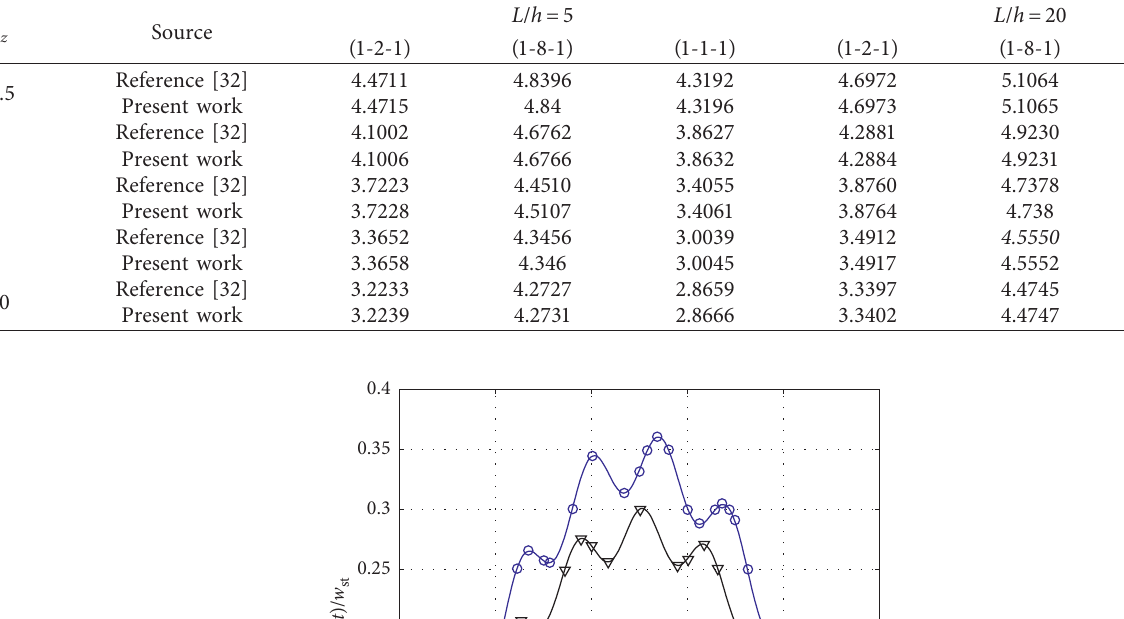
Table 2: Comparison of frequency parameter of unidirectional FGM Sandwich beam.